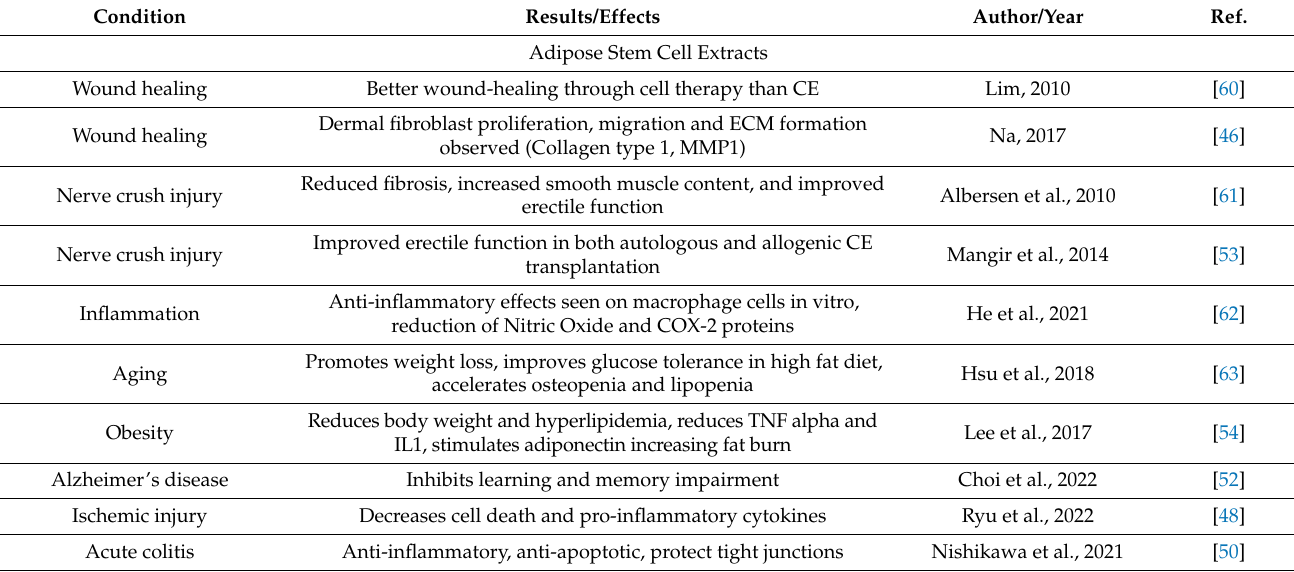
Table 1. Cell extract (CE) treatment for various